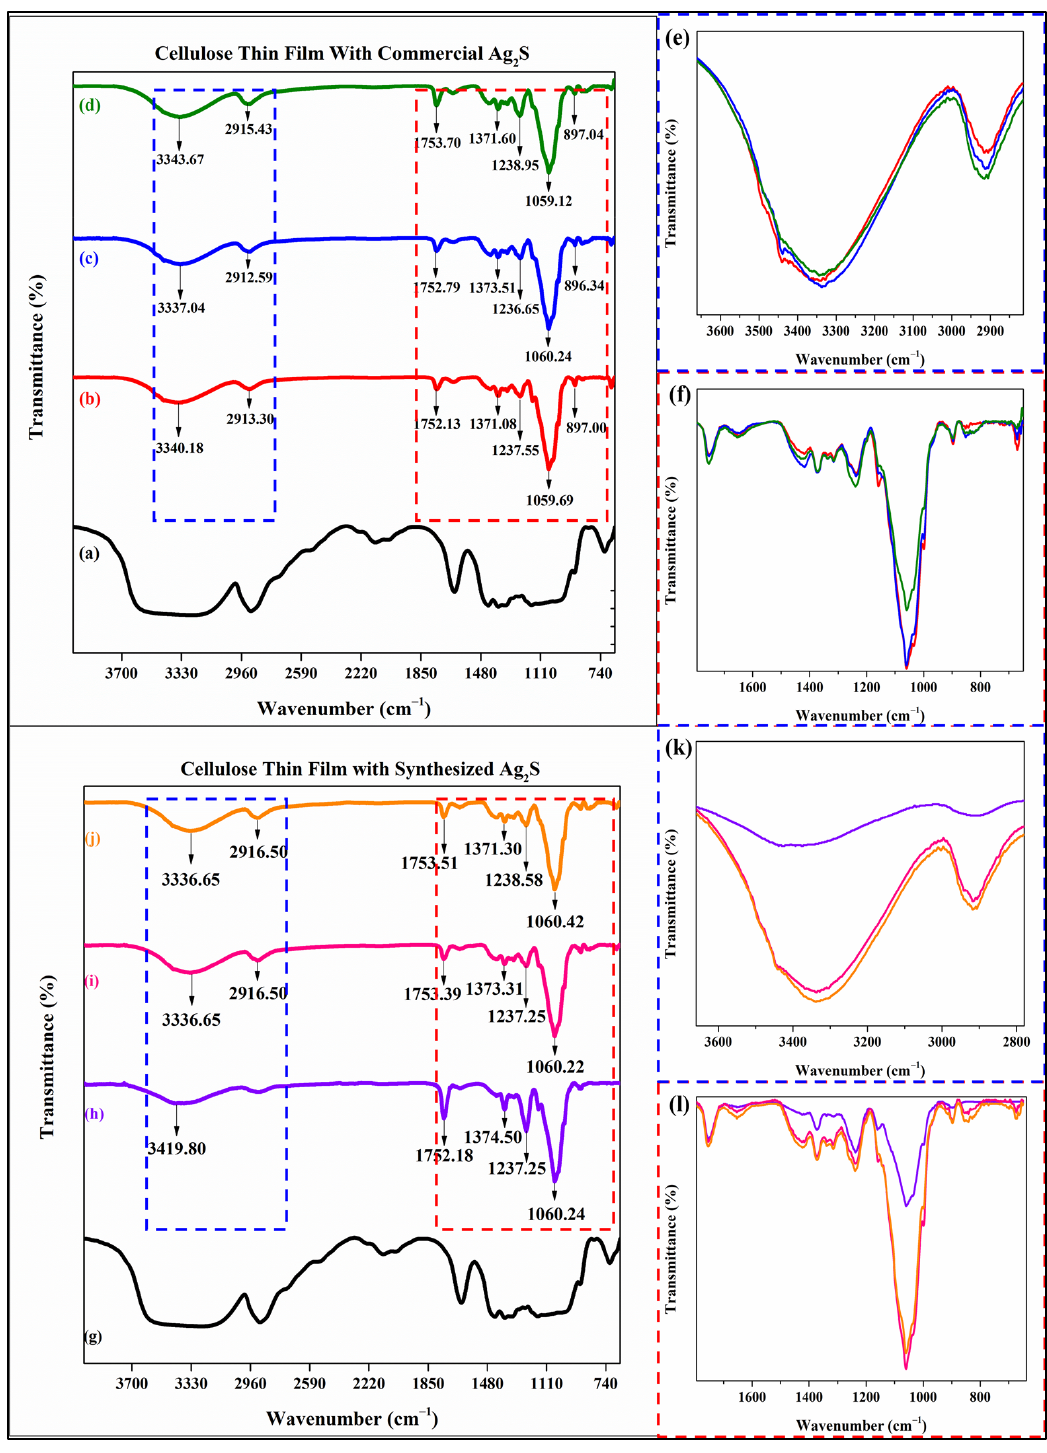
Figure 6. ATR—FTIR spectra of: ( a , g ) cellulose, ( b ) CF/comAg 2 S1, ( c ) CF/comAg 2 S2, ( d ) CF/comAg 2 S3, ( e , f ) inset CF/comAg 2 S graph, ( h ) CF/syntAg 2 S1, ( i ) CF/syntAg 2 S2, ( j ) CF/syntAg 2 S3, and ( k , l ) inset CF/syntAg 2 S graph. 3.5. Photocatalytic Degradation Mechanism of Methylene Blue Using the Cellulose/Ag 2 S